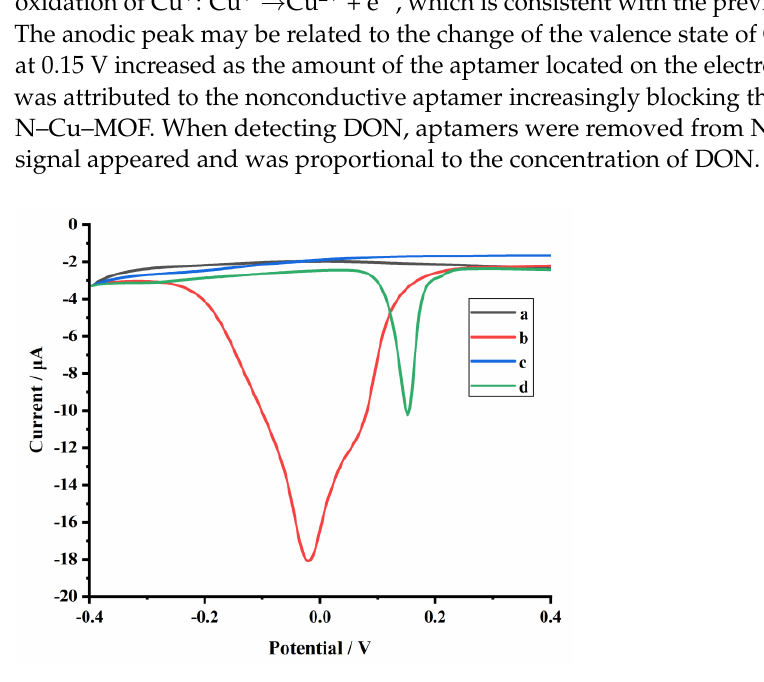
Figure 3. Differential pulse voltammetry (DPV) measurements of the glassy carbon electrode (GCE) with different modifications: ( a ) GCE, ( b ) N–Cu–MOF/GCE, ( c ) AP1/N–Cu–MOF/GCE in 1 mmol L −1 PBS (pH 5.0) and ( d ) AP1/N–Cu–MOF/GCE is in PBS (1 mmol L −1 , pH 5.0) containing 10 ng mL −1 DON.